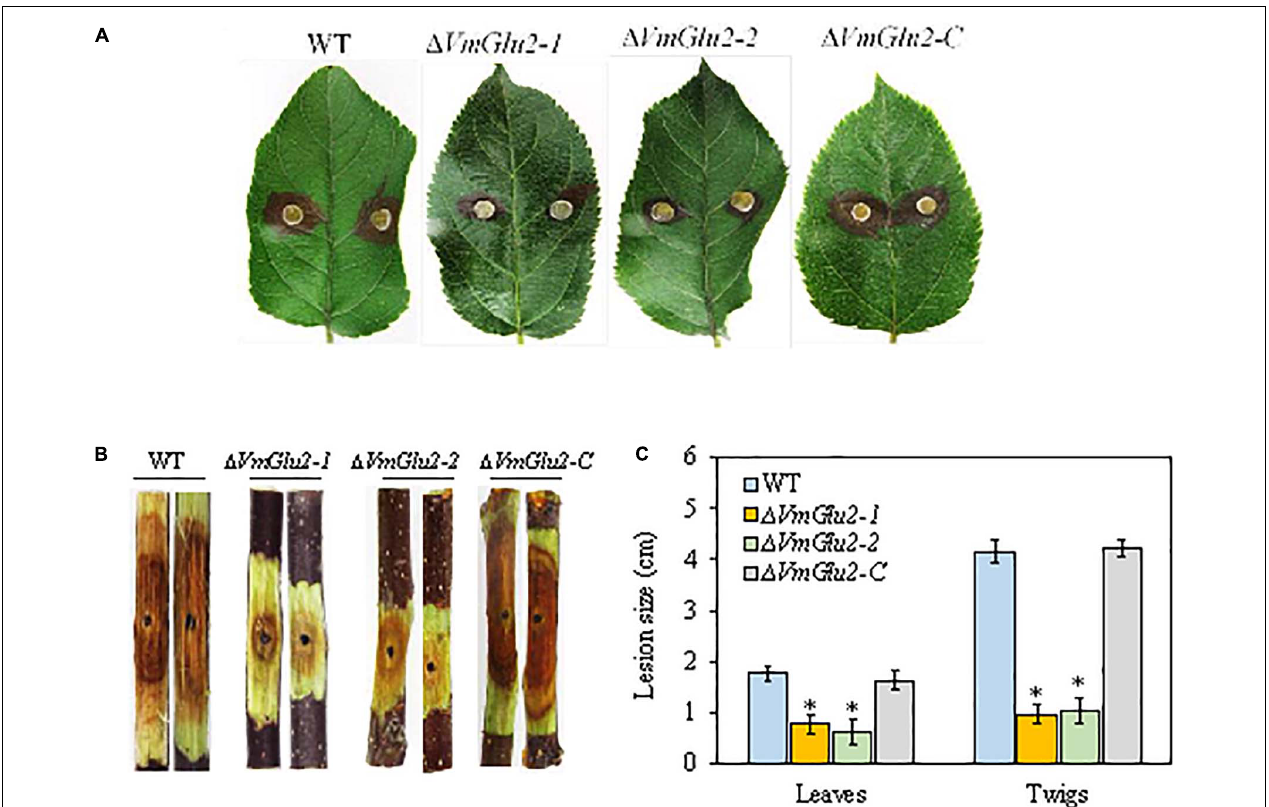
FIGURE 5 | Pathogenicity tests of the WT, VmGlu2 deletion, and complementation mutants on the leaves and twigs of M. domestica Borkh. cv. Fuji. (A) The infected phenotype of apple leaves inoculated with different strains at 3 dpi. (B) The infected phenotype of apple twigs inoculated with different strains at 5 dpi. (C) Lesion sizes produced by different strains on apple leaves at 3 dpi and apple twigs at 5 dpi. The mean lesion length was calculated from 7 apple leaves and 12 apple twigs. Bars represent the standard deviation. Asterisks indicate significant differences with the wild-type strain ( P <